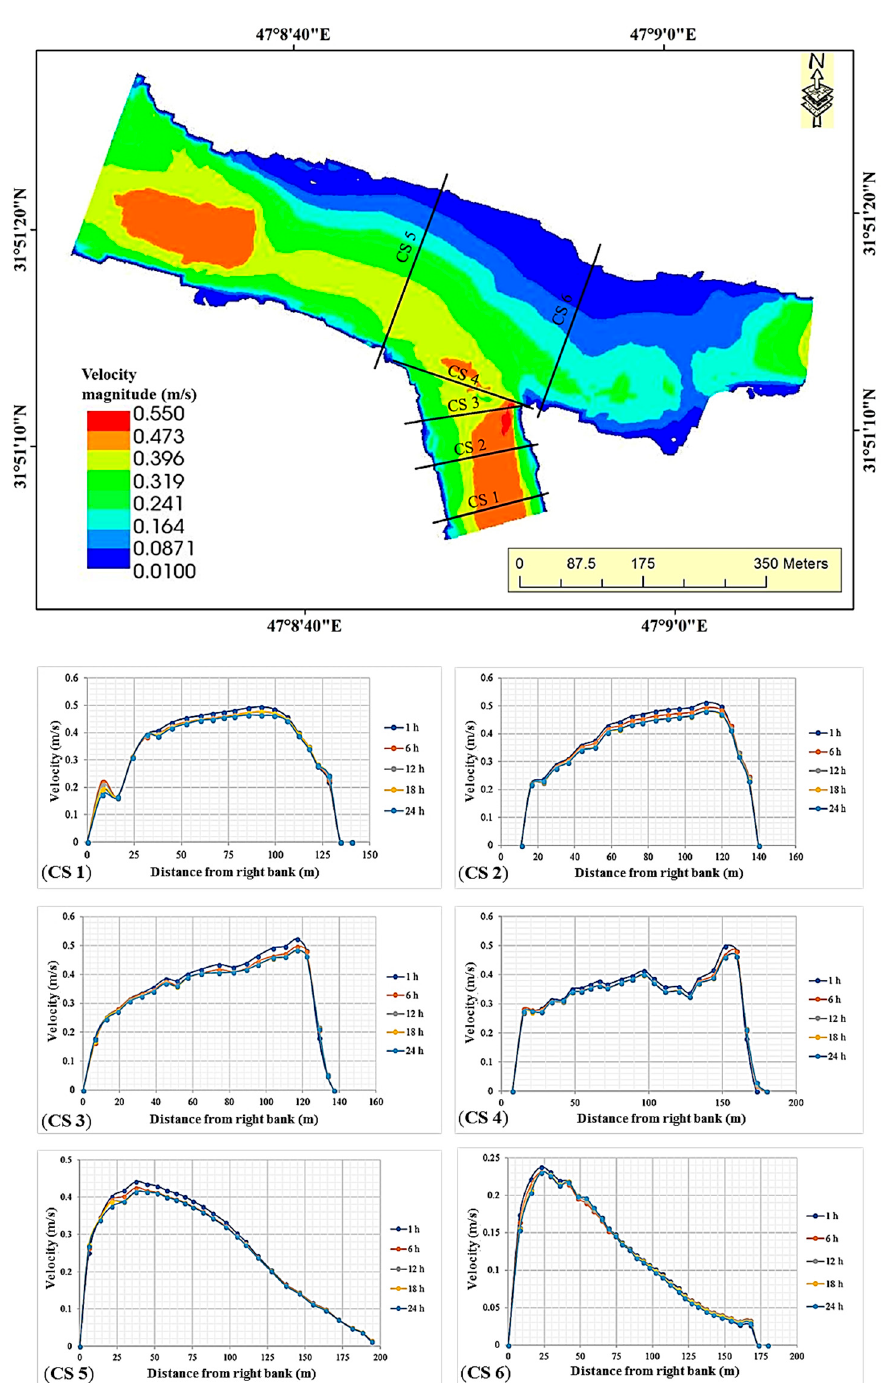
Figure 7. Simulation results for velocity magnitude at the Tigris branching junction and profiles of average flow velocity in m / s within 24 h at cross-sections CS 1, CS 2, CS 3, CS 4, CS 5, and CS 6.